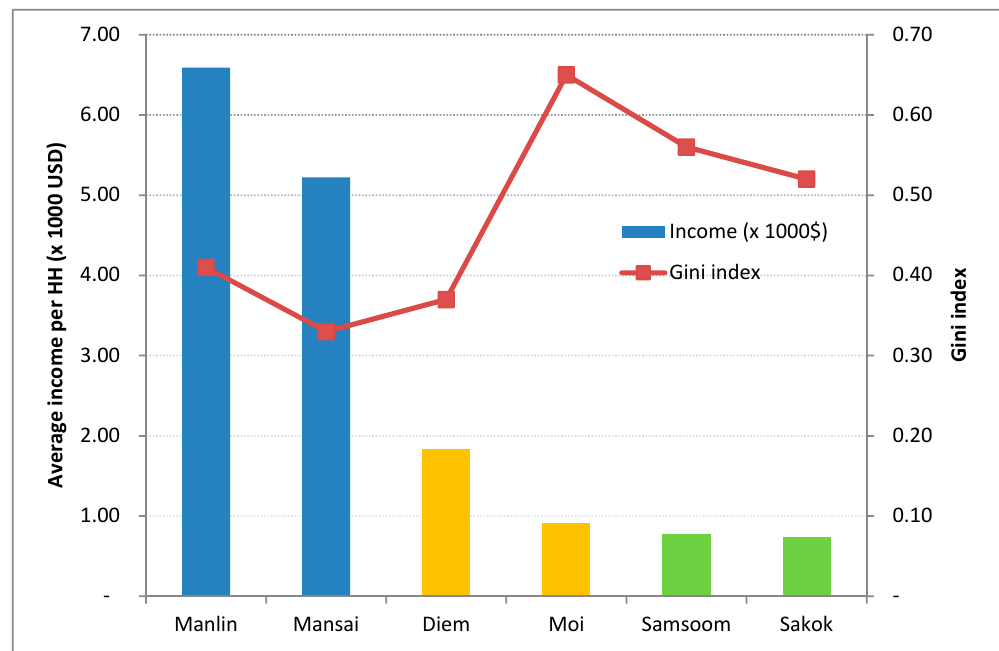
Figure 6 : Average annual household income in study sites and Gini index. Figure 6. Average annual household income in study sites and Gini